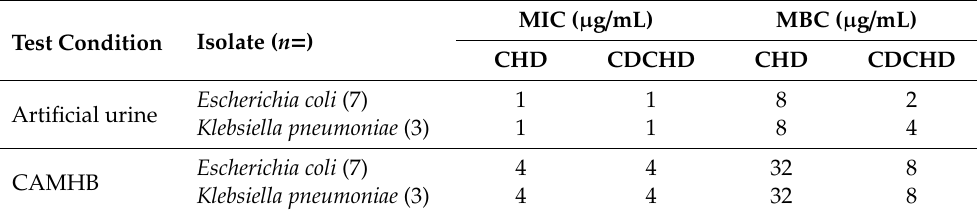
Table 2. Minimal inhibitory concentrations (MICs) and minimum bactericidal concentrations (MBCs) of CHD and CDCHD determined for 10 clinical isolates (selected from strain panel shown in Table 1) in artificial urine (pH 6.5) and standard CAMHB medium. Values denote medians of three independent measurements per